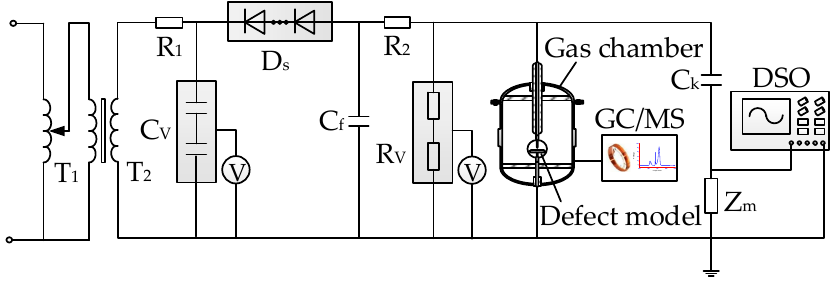
Figure 1. Experimental platform of SF 6 decomposition under negative DC-partial discharge (PD).